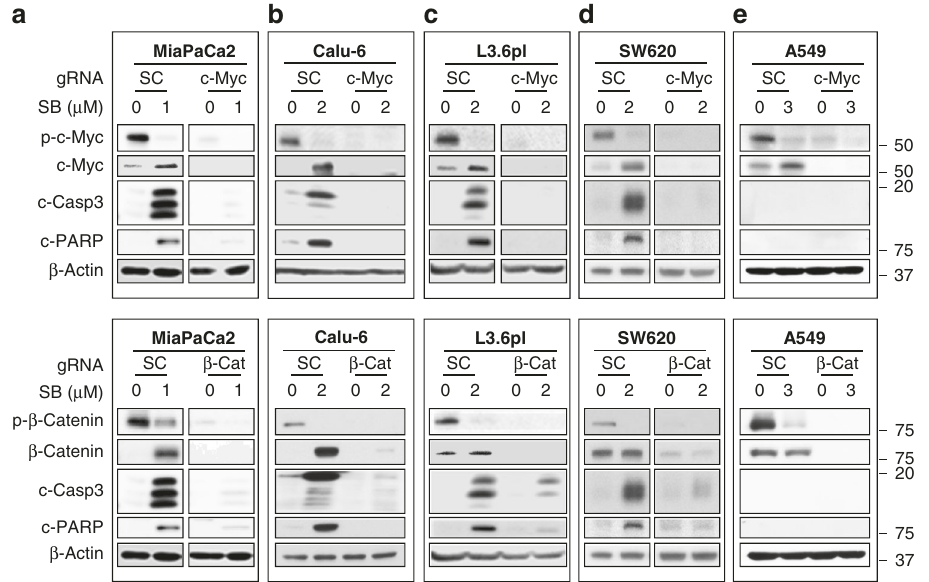
Fig. 6 CRISPR/Cas9 knockout of β -catenin or c-Myc rescues from SB-induced apoptosis. a – e Western blots of MiaPaCa2 ( a ), Calu-6 ( b ), L3.6pl ( c ), SW620 ( d ), and A549 ( e ) cells treated with SB at indicated concentrations for 48 h after knocking out c-Myc (top panel) or β -catenin (bottom panel) with lentiviral guide RNAs (gRNAs), including scrambled (SC), β -catenin ( β -Cat), and c-Myc gRNAs. Experiments were repeated at least three times for all cell lines except for SW620 and A549 where they were done